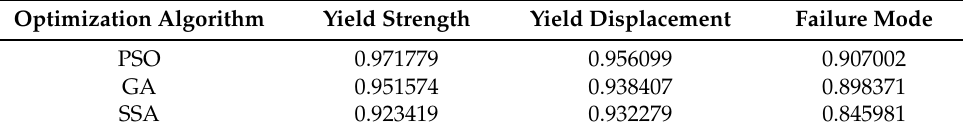
Table 4. Correlation coefficient of PSO, GA, and